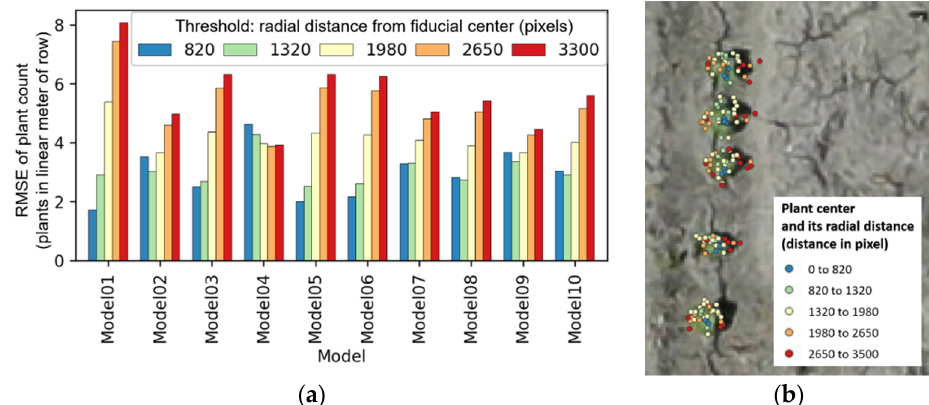
Figure 11. Relation of radial distance threshold and average root mean square error (RMSE) of plant count ( a ); an example showing its effect on plant centers derived from Model 1 ( b ).